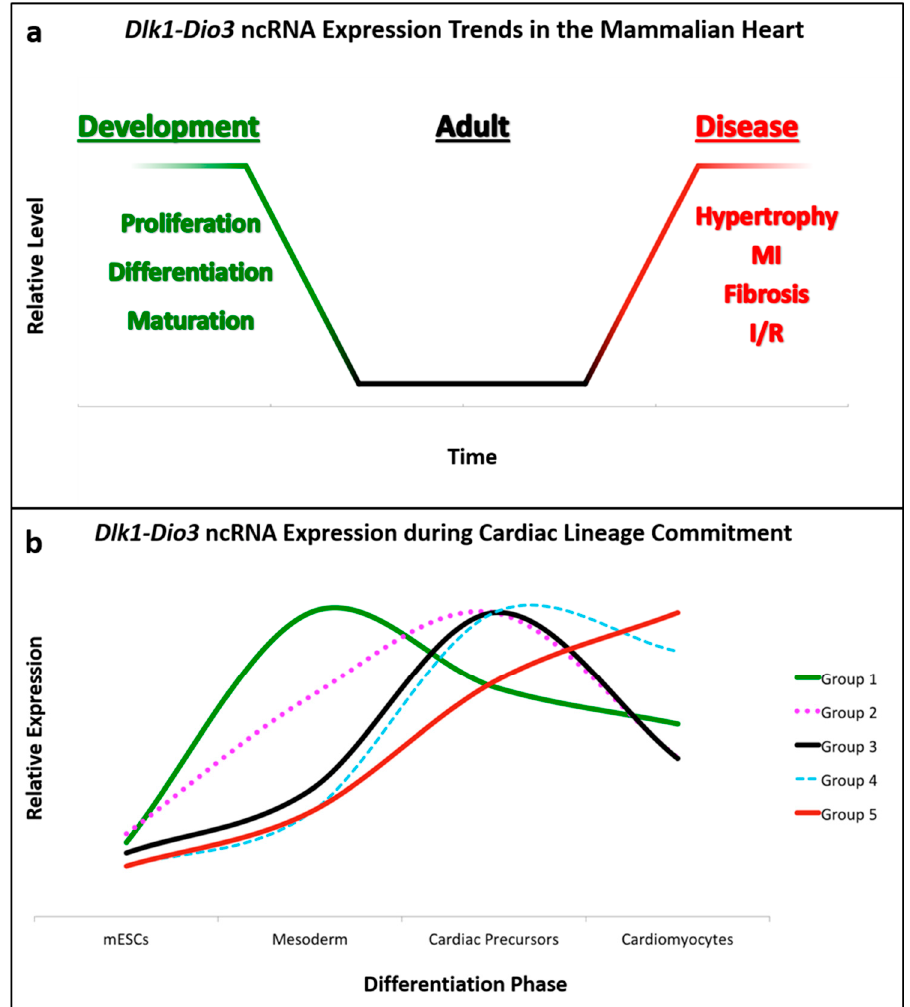
Figure 2. Dlk1-Dio3 ncRNA Expression in the Heart and Cardiomyocyte Differentiation. ( a ) General trends of locus ncRNA expression over time: Many ncRNAs are expressed at their highest levels during fetal and early-postnatal cardiac development, and are gradually downregulated to low basal levels during adulthood. However, disease or stress triggers marked upregulation of numerous locus ncRNAs. ( b ) Locus ncRNAs are dynamically expressed throughout phases of cardiomyocyte lineage commitment and differentiation. This plot was generated using supplementary data from Wamstad et al. [62], which analyzed the transcriptome during cardiomyocyte-directed differentiation. To generate the plot, raw values of individual ncRNAs were normalized to their maximal expression, and subsequently grouped by the differentiation phase at which maximal ncRNA expression was reached. The relative levels conveyed represent the average of all ncRNAs within a given group, and are comprised as follows: Group 1 = miR-1906, -770, -493, -337, -540, -665, -432, -1188, -882, -299, -380-5p, -323-5p, -758, -679, -666, -654, -544, -485, -453, -412, and -369-5p; Group 2 = miR-673-5p, -341, -370, -494, -667 + , -376b + , -300 + , -and 541; Group 3 = miR-431 + , -127 + , -434-5p + , -1197, -323-3p ++ , -1193 ++ , -543 ++ , -495 ++ , -539, -134 + , -668, -496, -409-3p, and -410 + ; Group 4 = Gtl2, miR-379 + , -411 + , -376c ++ , -376a + , -381 + , and -382 + ; Group 5 = miR-433 + , -136 ++ , -380-3p, -487b + , -154 + , -377 + , -409-5p + , and -369-3p ++ . To account for levels, ncRNAs annotated with “+” indicate measurements over 100 reads, and “++” for over 1000 reads. Although groups 2, 3, and 4 all peak in cardiac precursors, these ncRNAs were subdivided into groups based on striking differences in expression levels during the mesoderm (early) and cardiomyocyte (later) phases. These ncRNA patterns illustrate the dynamic regulation of the locus. Consistent with the high levels reported in the fetal and postnatal heart, locus ncRNAs are enriched in later phases of cardiac